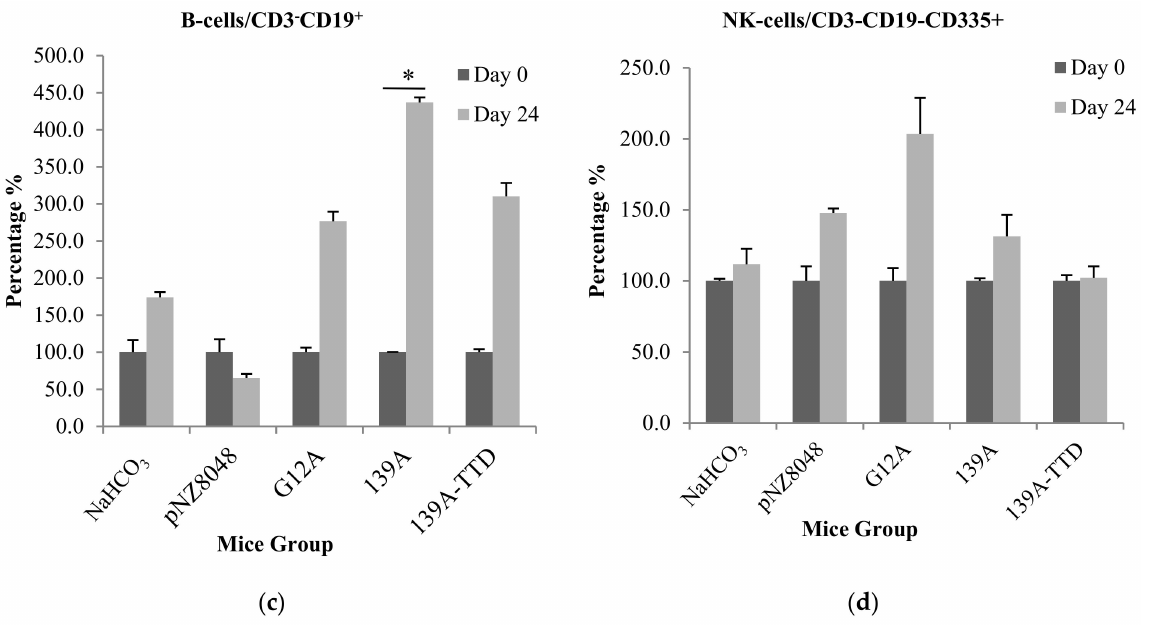
Figure 3. Immunophenotyping profile of mice whole blood before (pre-immunized) and after oral administration (post-euthanized) of L. lactis expressing K-ras control (G12A) and K-ras therapeutic mimotopes (139A, 139A-TTD). Bar charts depicts immune cell population of ( a ) B-cells/CD3 − CD19 + ( b ) helper T-cells/CD3 + CD4 + ( c ) cytotoxic T lymphocytes/CD3 + CD8 + and ( d ) Natural killer cells/CD3 − CD19 − CD335 + . Mice groups fed with sodium bicabornate solu- tion and L. lactis harboring empty vector pNZ8048 served as negative controls. Results were expressed as mean percentage (%) ± standard deviation of immune cell populations of 3 mice between pre-immunized and post-euthanized mice whole blood. (*) represents significantly different mean values ( p -value ≤ 0.05) between pre-immunized and post-euthanized mice whole